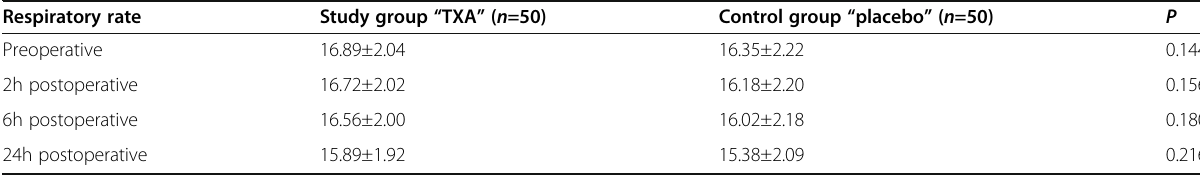
Table 8 Respiratory rate in the two groups all through the procedure Respiratory rate